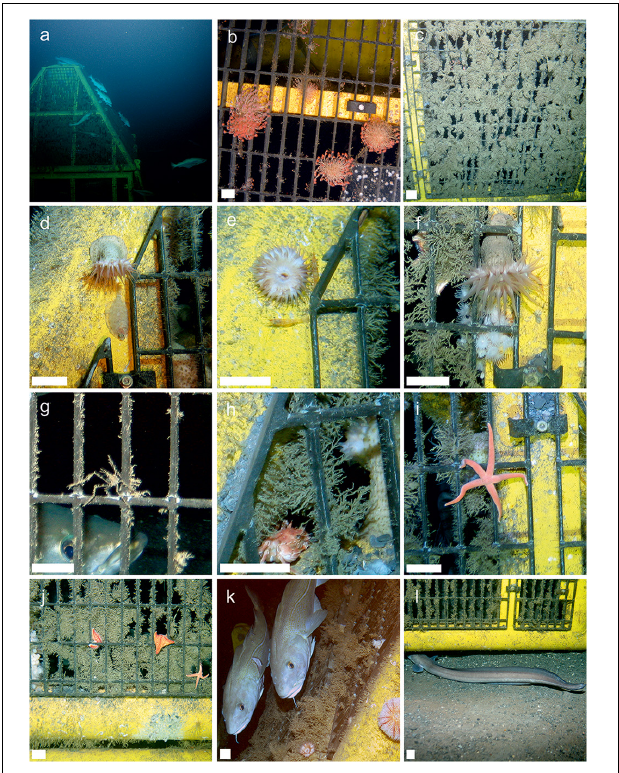
FIGURE 4 | In situ observations of protective structures. Scale bar on images b-l = 35 mm. (a) Structure A and fishes viewed from distance, (b) hydroid growth photographed on structure B, (c) hydroid turf covering a panel on the protective structure, (d) Actinauge richardi (Hormathiidae) and an unidentified flatfish, (e) A. richardi and two unidentified decapods, (f) A. richardi , hydroid turf and Parazoanthus sp., (g) Macropodia tenuispinis and Pollachius virens , (h) hydroid turf and the crab Bathynectes maravigna , (i) Stichastrella rosea , (j) Porania pulvillus, S. rosea and Parazoanthus sp., (k) Atlantic Cod, Gadus morhua and echinoid, (l) European Conger ( Conger conger ) entering structure through scoured